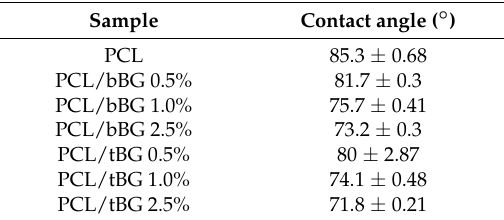
Table 4. Water contact angle values of PCL and its nanocomposites.